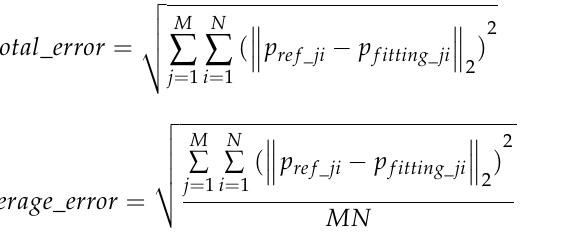
The green arc in Figure 6 represents the geometric fitting result overlaid on the 1164 extracted points. Note that the green dot in Figure 6 represents the center of the green arc, and the algebraic fitting result is omitted in Figure 6 because it is almost the same as the geometric fitting result. The point cloud in Figure 6 is an approximately ± 3 ∼ 4 mm thick band from the green arc, which agrees with accuracy of the depth of the RGB-D camera